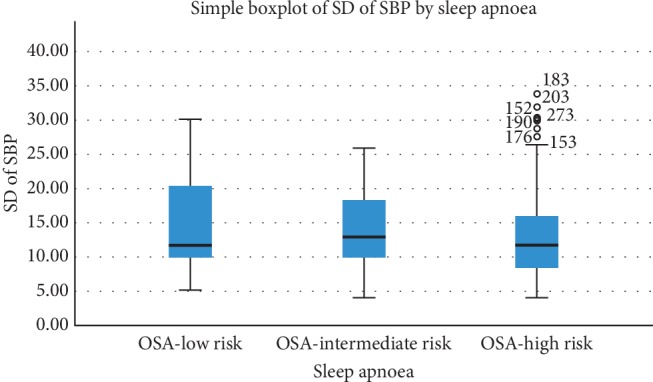
Variation of SD by sleep apnoea.